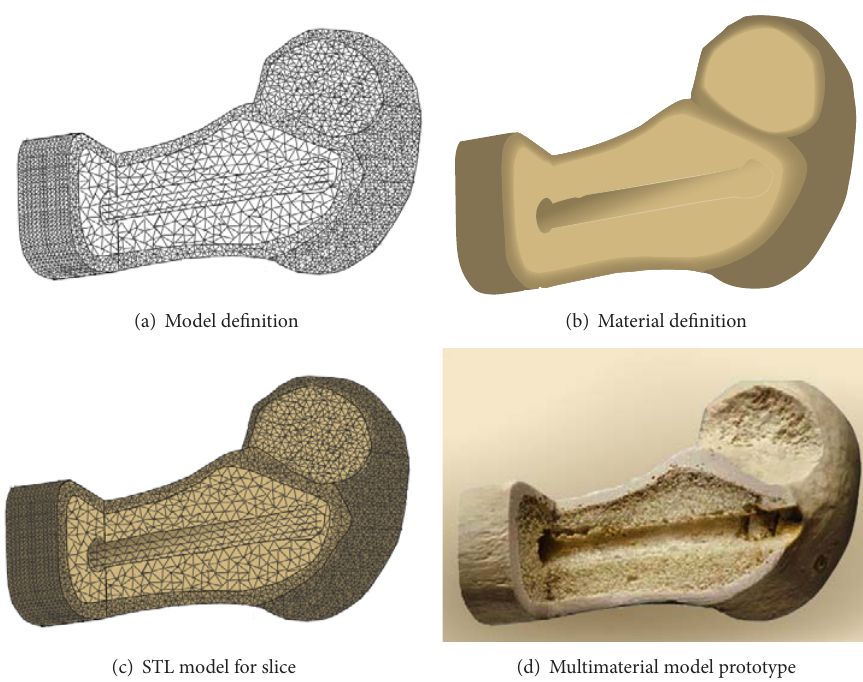
Figure 6: Heterogeneous objects model color prototypes.